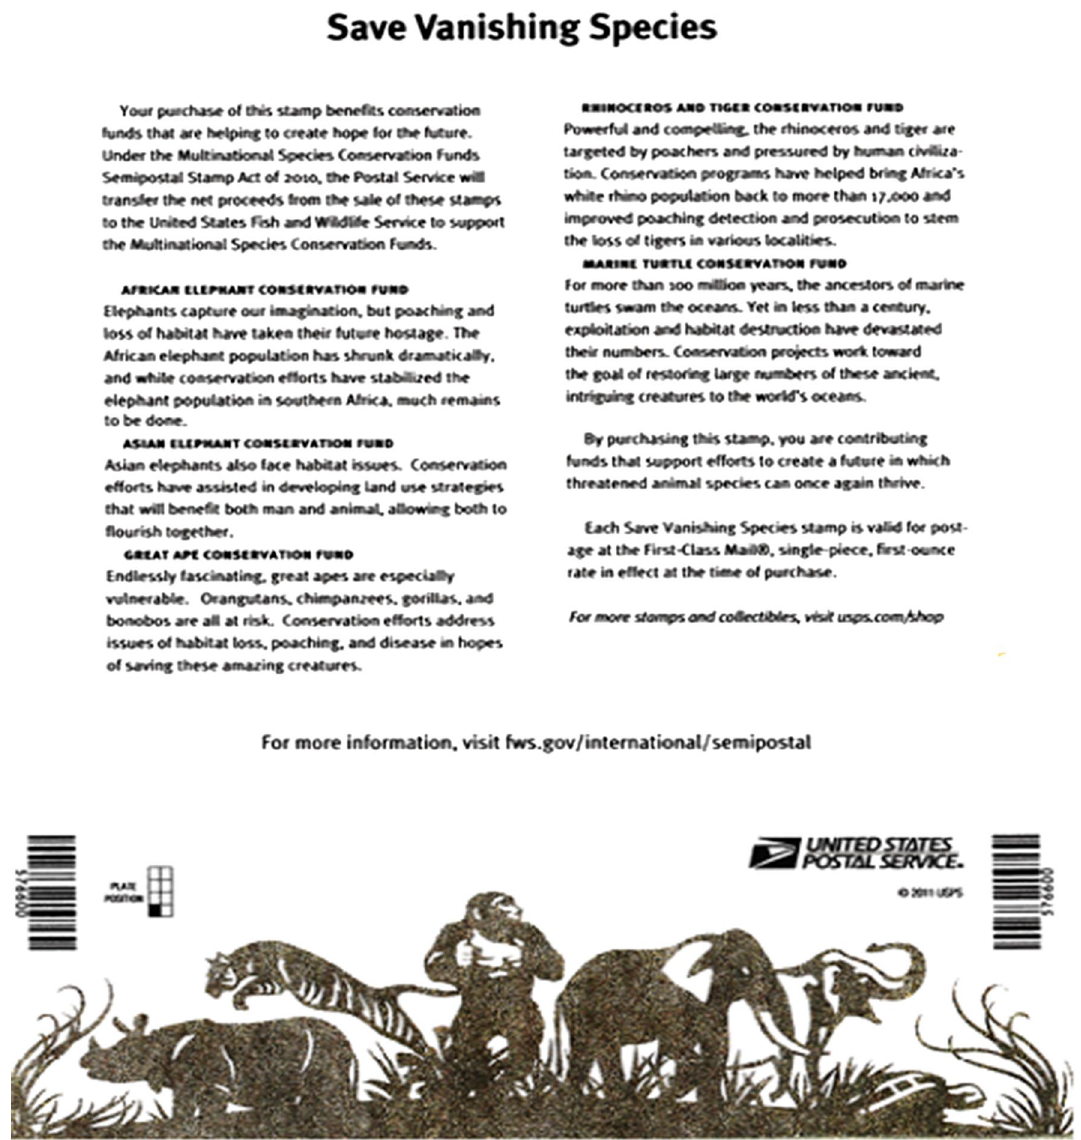
Fig. 2 Reverse side of the Amur tiger cub stamp, explaining the Multinational Species Conservation Funds and how purchasing stamps go towards conservation of six